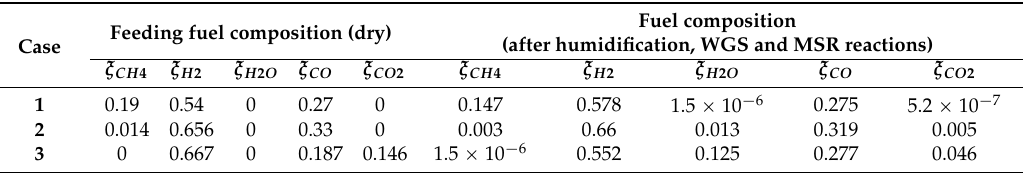
Figure 6. Further model validation using three different fuel compositions, containing methane (Table 4). Operating temperature: 950 °C. Fuel flow rate 10 Nl/min. Symbols: experimental. Lines: simulations. Table 4. Dry CH 4 /H 2 /CO/CO 2 feeding fuel compositions (experimental) and fuel composition after ambient temperature humidification and methane steam reforming (MSR) and WGS reactions at 950 ˝ C (calculated). Related to the results in Figure